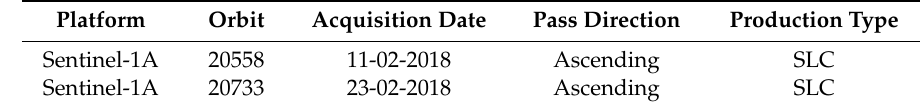
Table 4. Summary of datasets used for comparative testing.